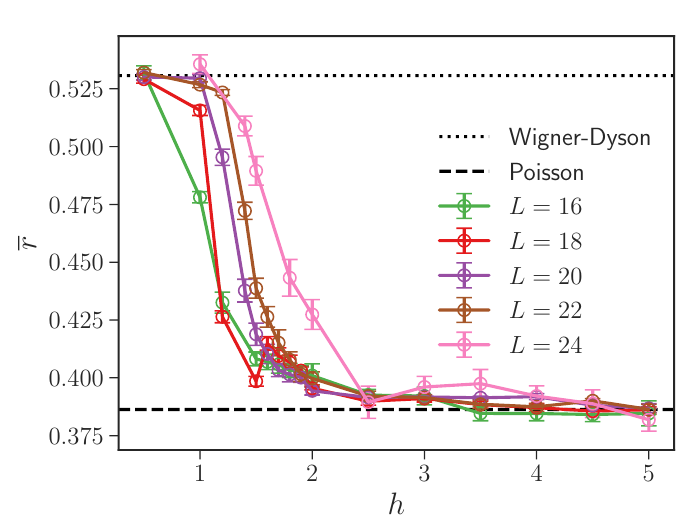
Figure 4: Gap ratio (averaged over states around energy density ε = 0.5) as a func- tion of on-site potential strength, for various system sizes. Gap ratio value for the Wigner-Dyson and Poisson statistics are indicated by dotted and dashed lines respec-